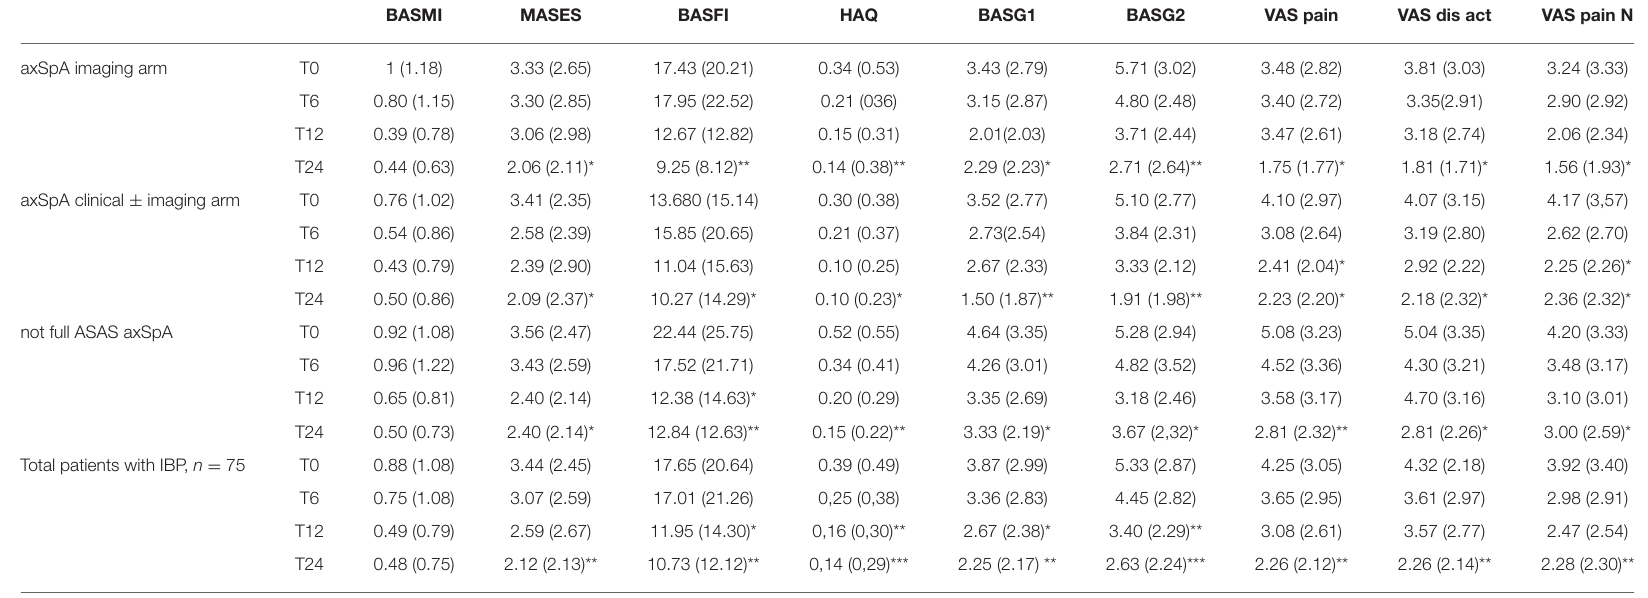
TABLE 5 | Values of clinical and functional indices from T0 to T24 in the whole group of patients ( n = 75) and in three cohorts (axSpA imaging arm, axSpA clinical ± imaging arm, not full ASAS axSpA). BASMI MASES BASFI HAQ BASG1 BASG2 VAS pain VAS dis act VAS pain